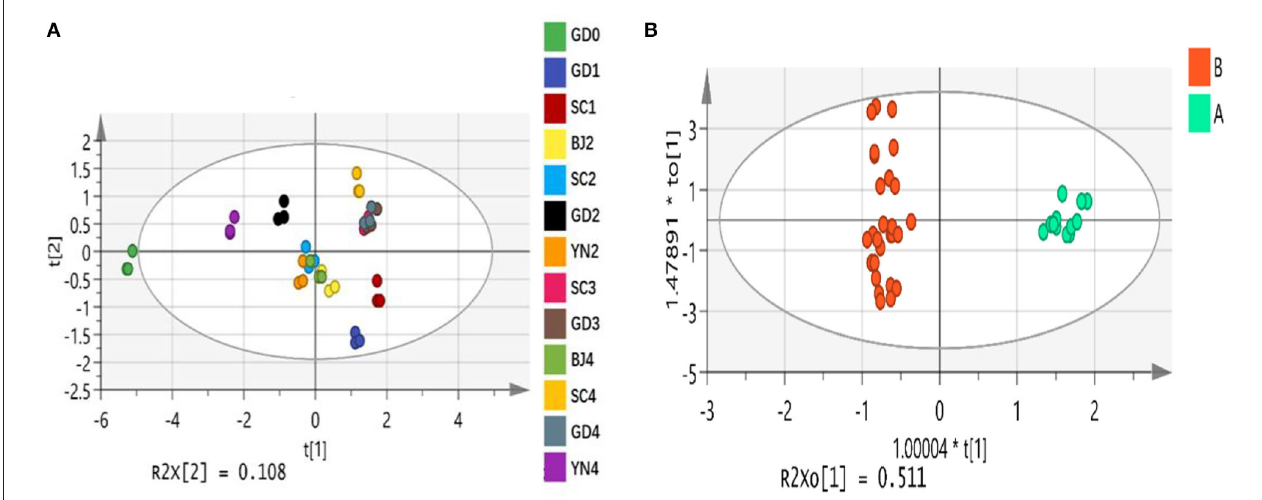
FIGURE 10 | (A) The principal component analysis scores plot of Citrus reticulata “Chachi” volatile oil samples in different aging time. (B) The orthogonal partial least square-discriminate analysis scores plot of Citrus reticulata “Chachi” volatile oil samples in different aging time.